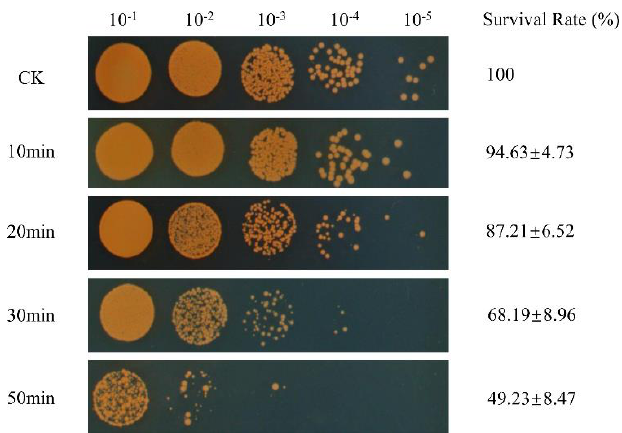
Figure 1. Survival phenotype plate assay of Deinococcus radiodurans exposed to 80 mM of H 2 O 2 for different shock times (0, 10, 20, 30, 50 min). CK: untreated sample control. The survival rate is expressed as the percentage of the number of colonies in the H 2 O 2 -treated samples compared with that in the untreated sample control. The survival rates of different samples were obtained from 10 −3 dilution with three independent repeats.